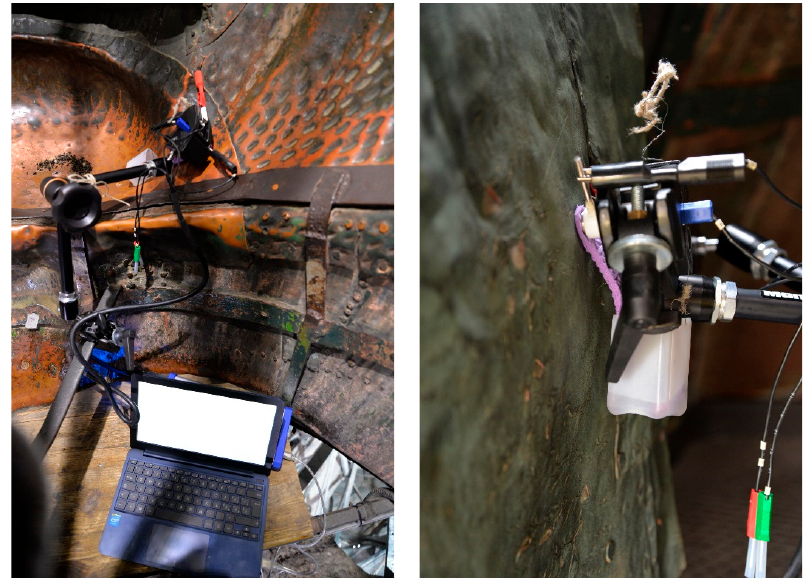
Figure 3. In situ electrochemical measurements with the contact probe.